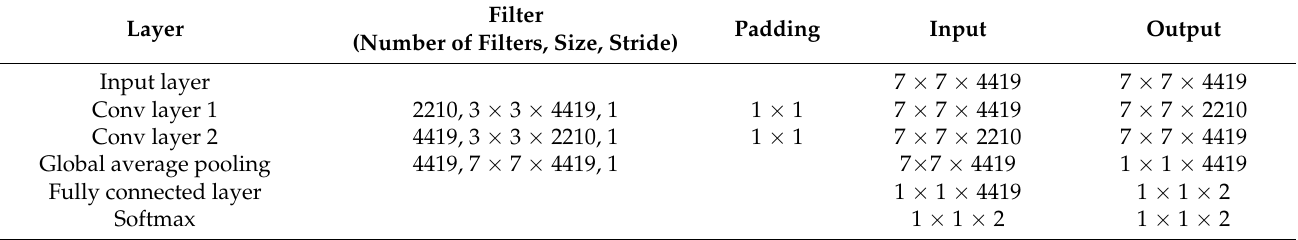
Table A3. Structure of